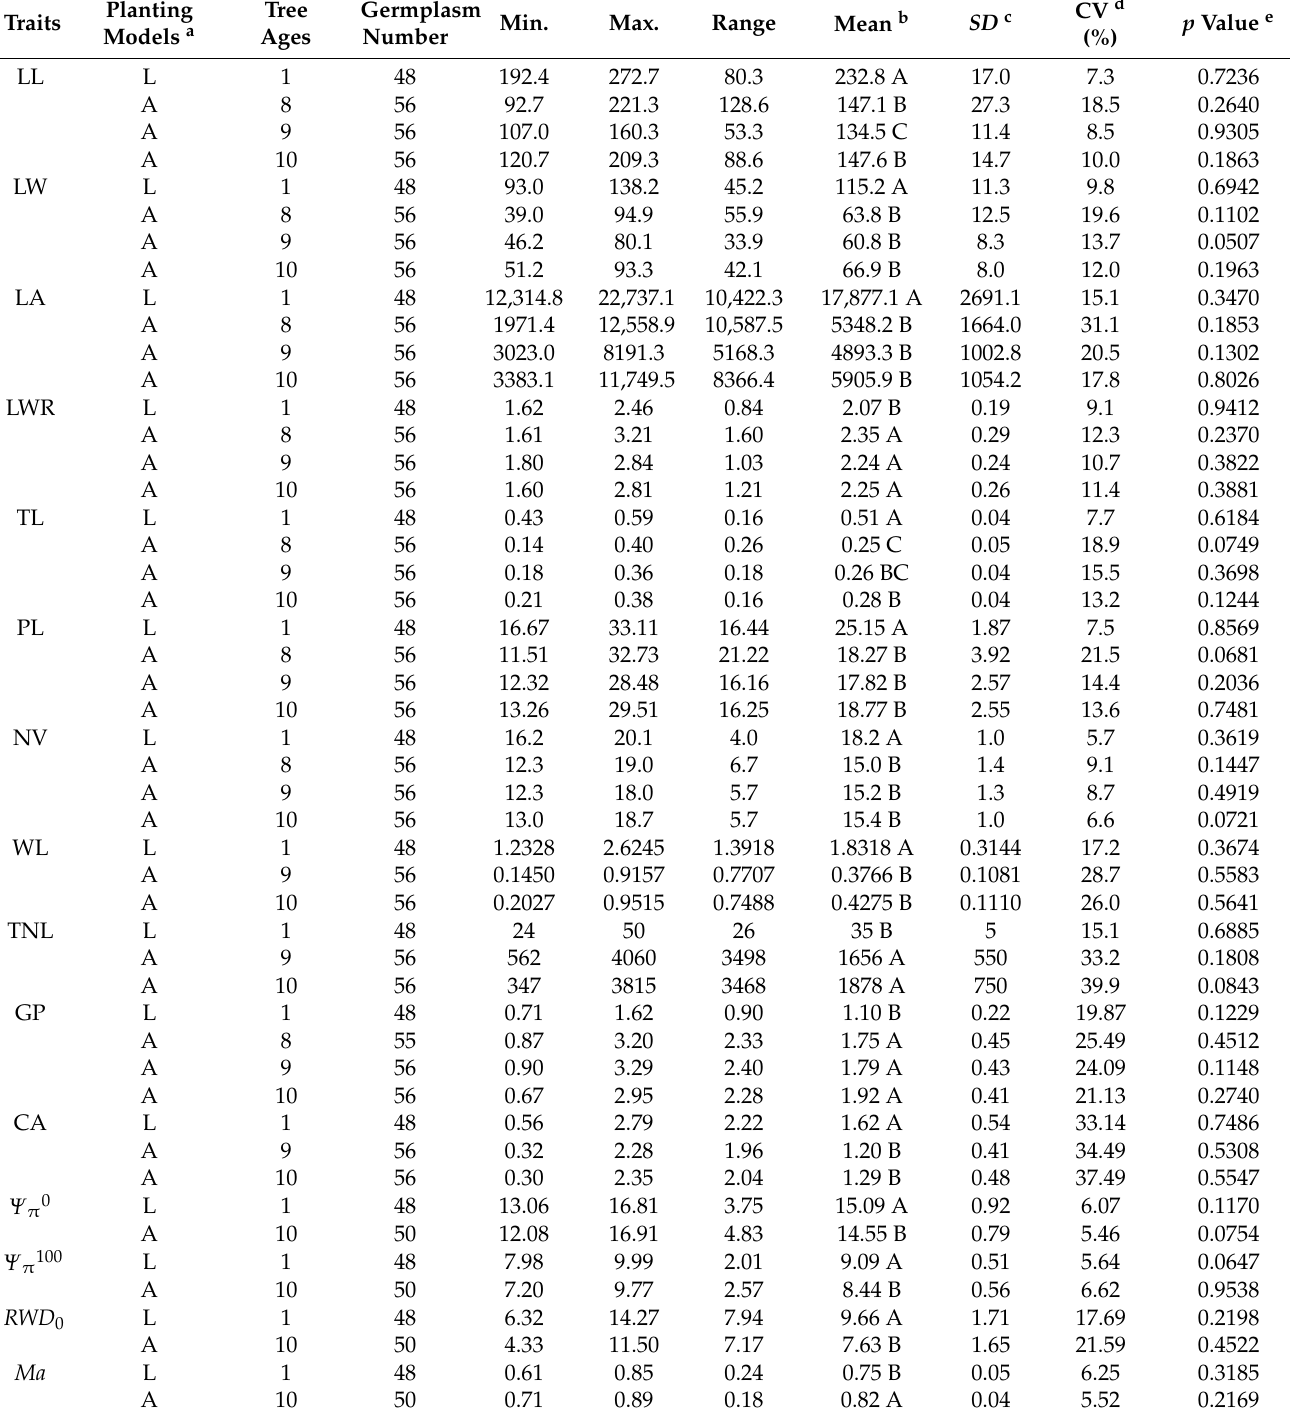
a “L” indicates the Leaf-oriented cultivation model, “A” indicates the Arbor forest model. b The same letter for the same trait indicates a non-significant difference, while different letters indicate an extremely significant difference at “ p < 0.01” level, according to Tukey HSD. c SD indicates standard deviation. d CV indicates coefficient of variation. e p value indicates the significance level of the normal distribution test. The same is